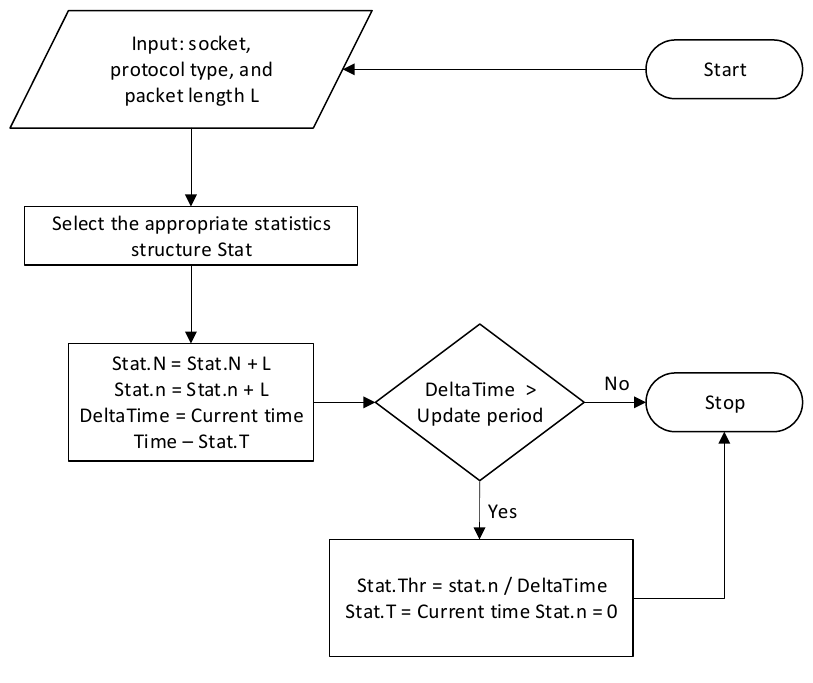
Figure 17. Statistics collection algorithm.